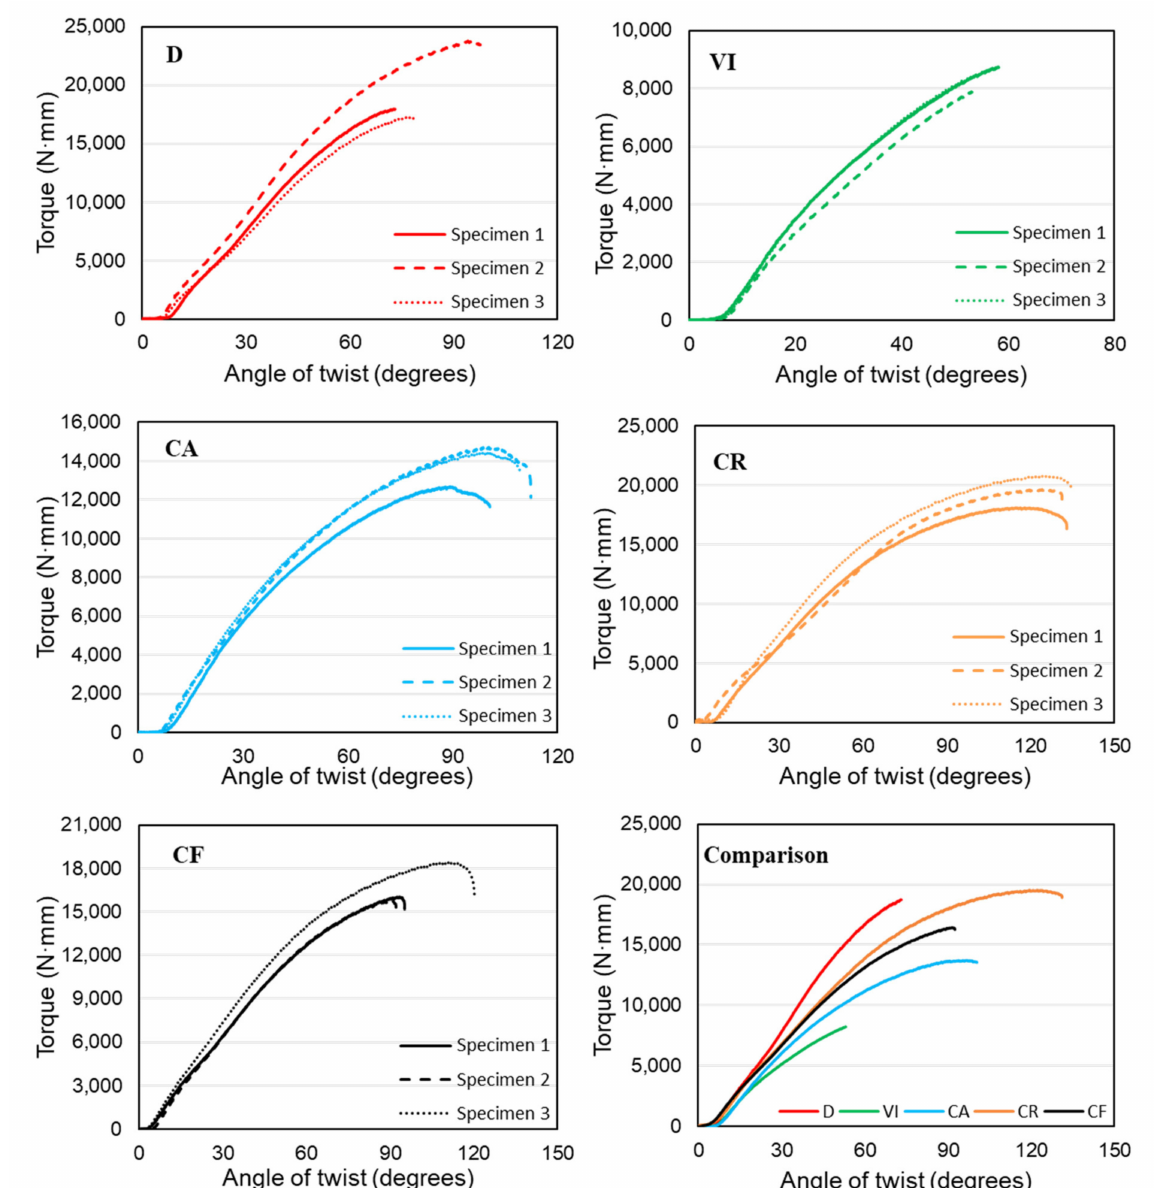
Figure 10. Experimental Torque-Twist curves of functionally gradient lattice